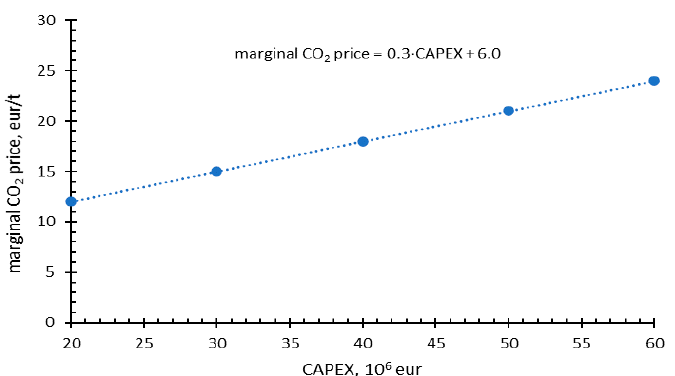
Figure 20. NPV vs. additional recovery after 15 years of CO2-EOR. By including different CAPEXs in the analysis, a linear correlation between CAPEX and marginal CO 2 price (Figure 21) was determined.